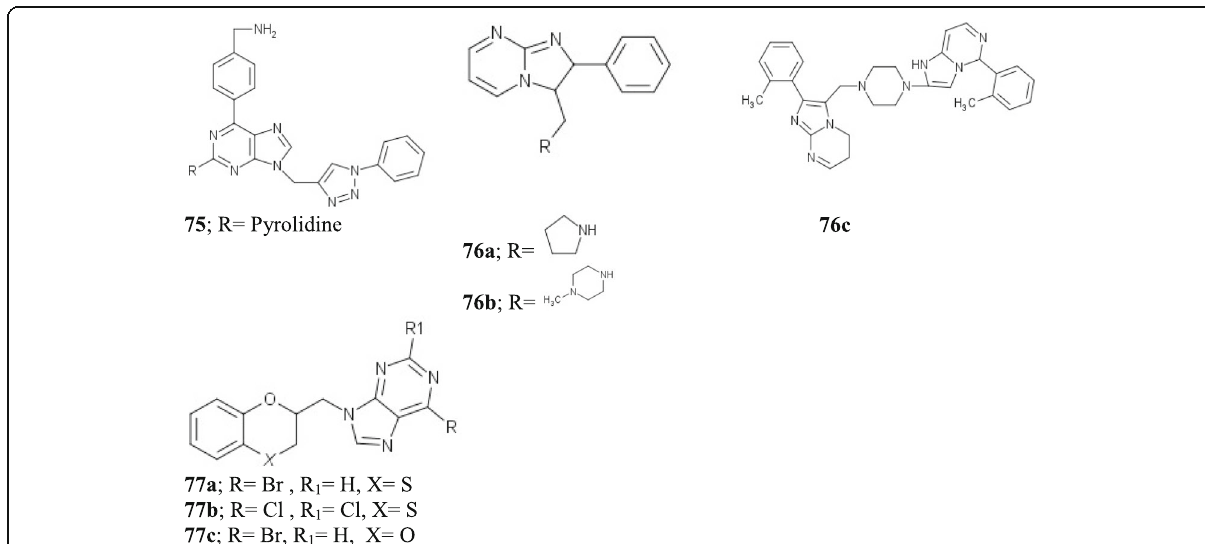
Fig. 25 Chemical structure of imidazolo-pyrimidine